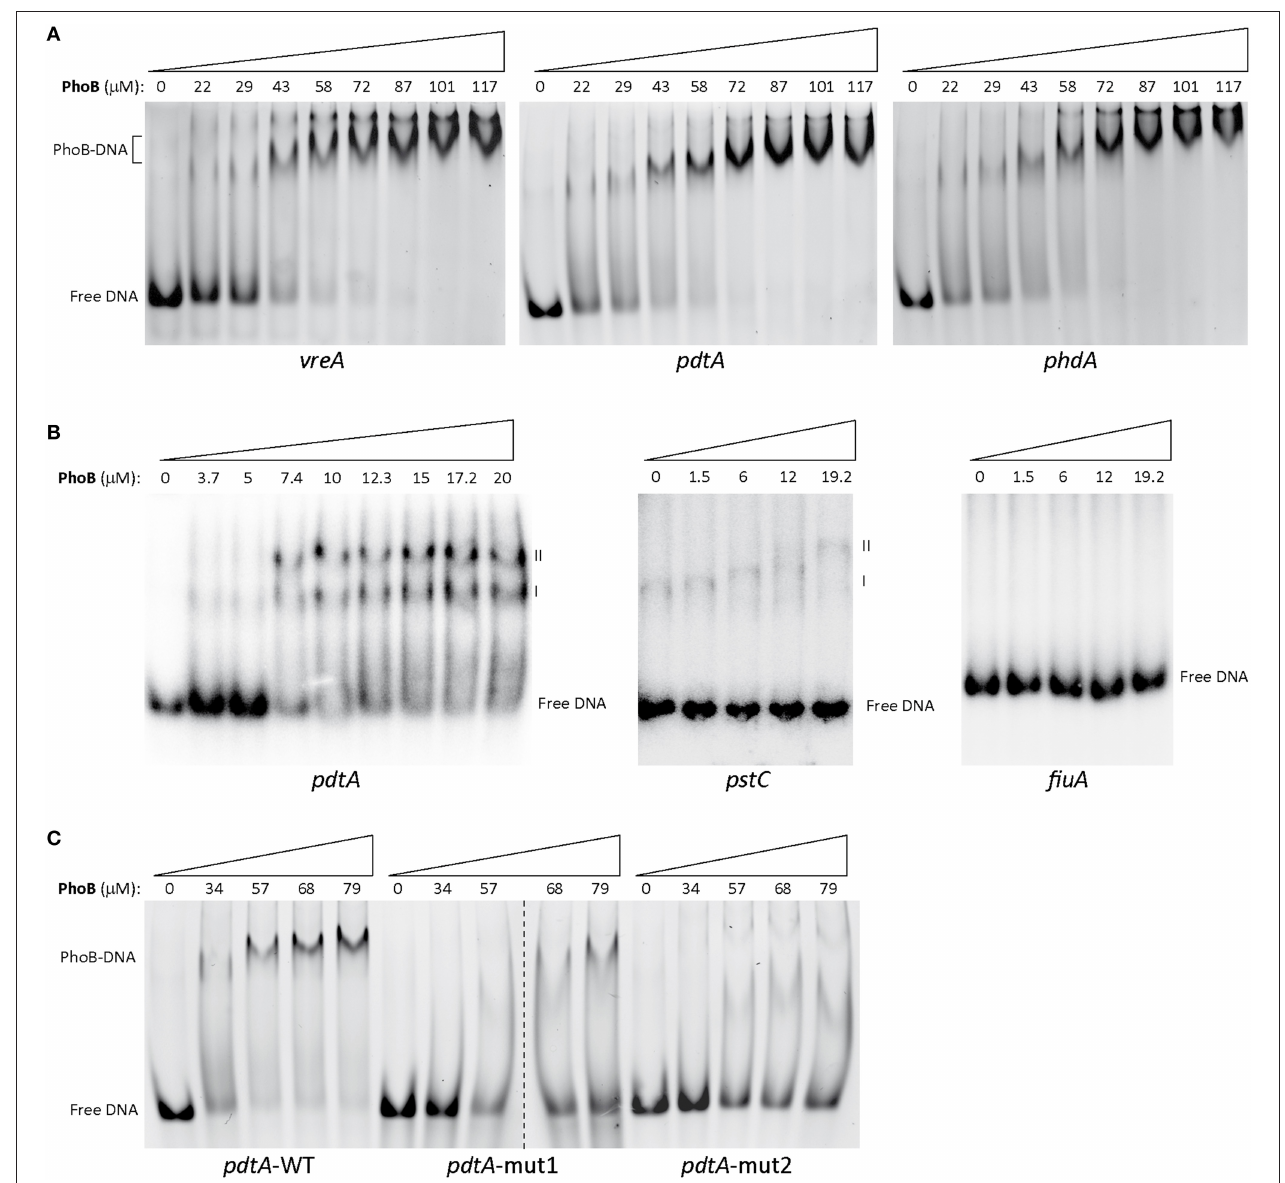
FIGURE 5 | Binding of PhoB to the vreA , pdtA and phdA promoter regions. EMSA gels using fluorescein-labeled (A and C) or 32 P-labeled (B) dsDNA probes (Table S2) containing the indicated P. aeruginosa promoter and increasing amounts of phosphorylated PhoB protein. Upper numbers indicate the concentration of PhoB used in the assay (in µ M). In A and B wild-type (WT) promoter sequences were used as DNA probes. In C pdtA promoters with mutations in the first direct repeat ( pdtA -mut1) or in both direct repeats ( pdtA -mut2) of the pho box were used. The position of the free DNA and of the PhoB-DNA complexes (I and II) are